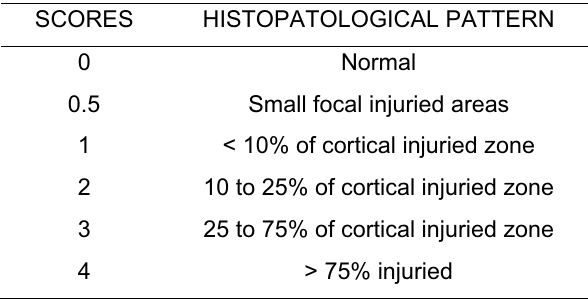
TABLE 1 - Scores used for histopathological